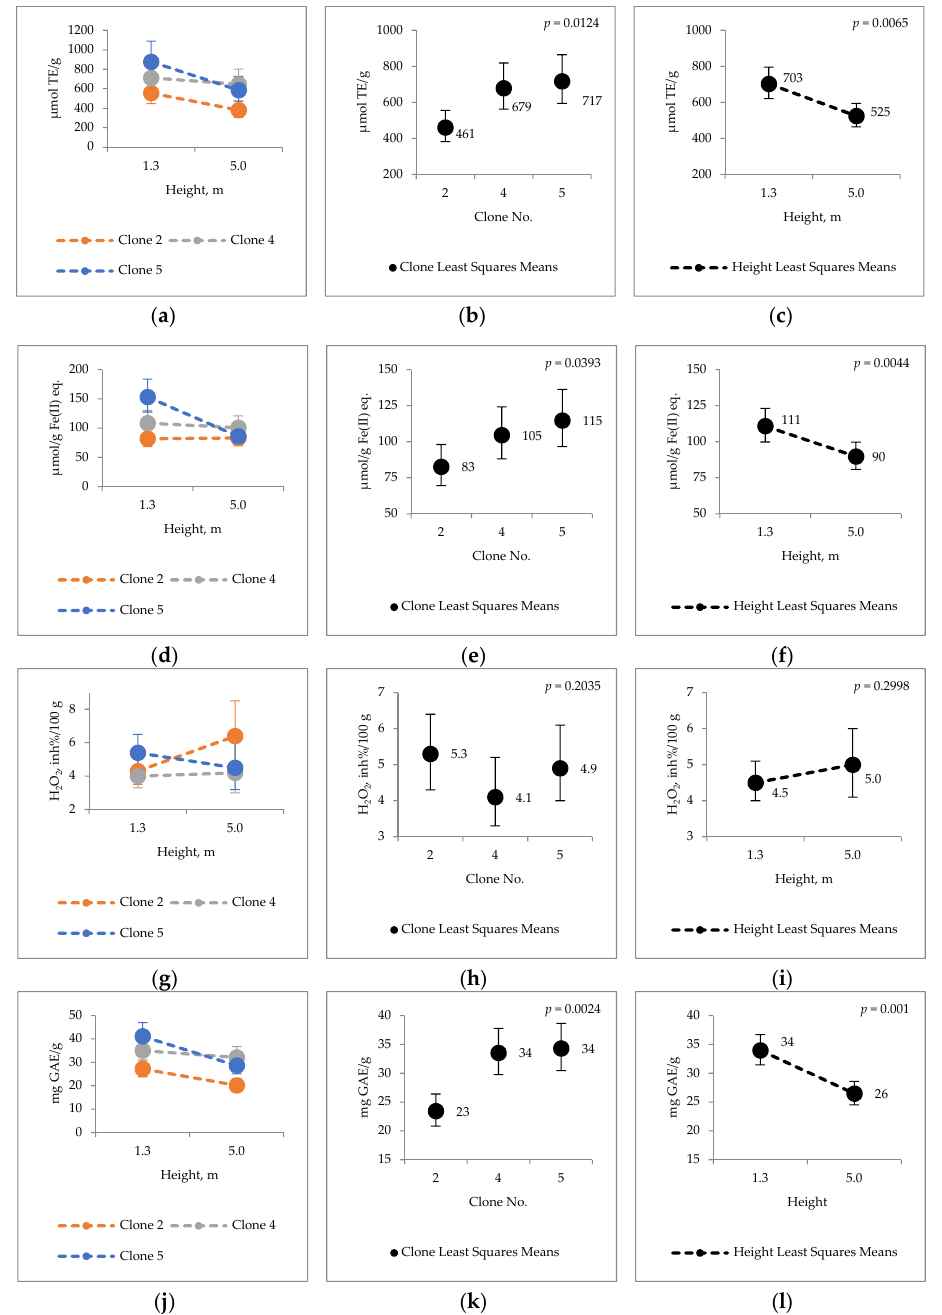
Figure 4. Hot water extract antioxidative capacity ( a – c ) ORAC µmol TE/g; ( d – f ) FRAP µmol/g Fe(II) eq.; ( g – i ) H 2 O 2 scavenging H 2 O 2 inh % per 100 g; ( j – l ) Total phenolic content mg GAE/g.